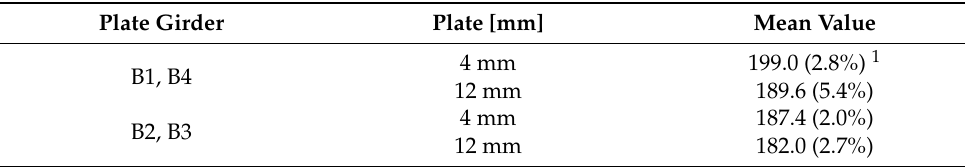
Table 3. Mechanical properties of steel—Young’s modulus